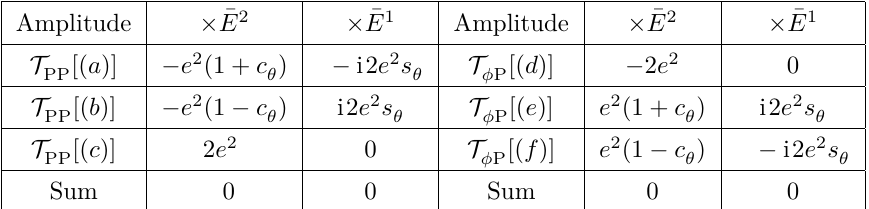
→ φ − A a ] = T [( d )] + T [( e )] + P P φ P φ P